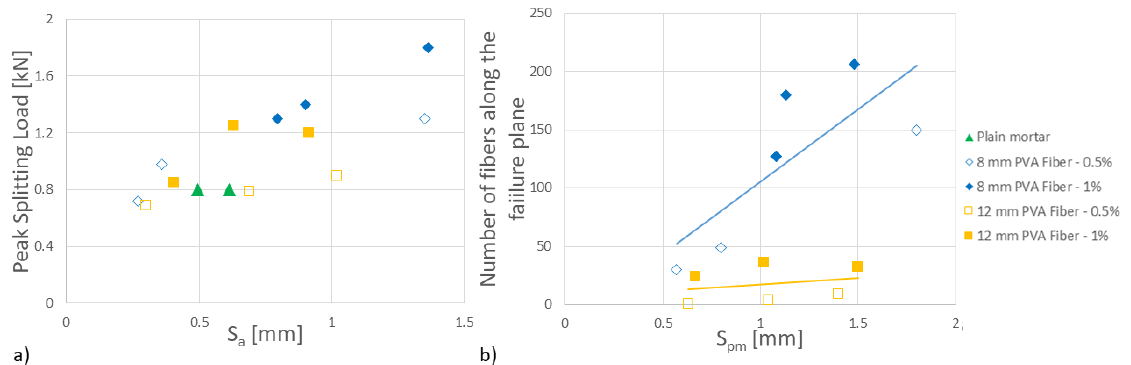
Figure 12. ( a ) Peak splitting load versus S a and ( b ) number of PVA fibers along the failure plane after testing vs. S pm .